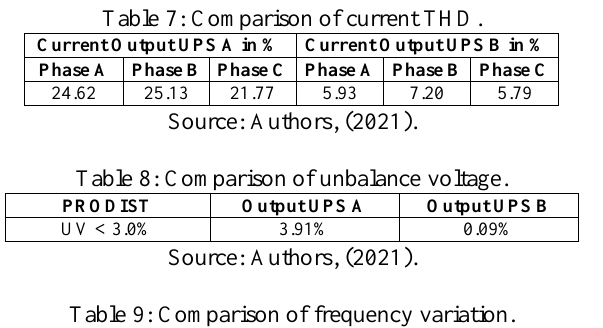
Table 7: Comparison of current THD.